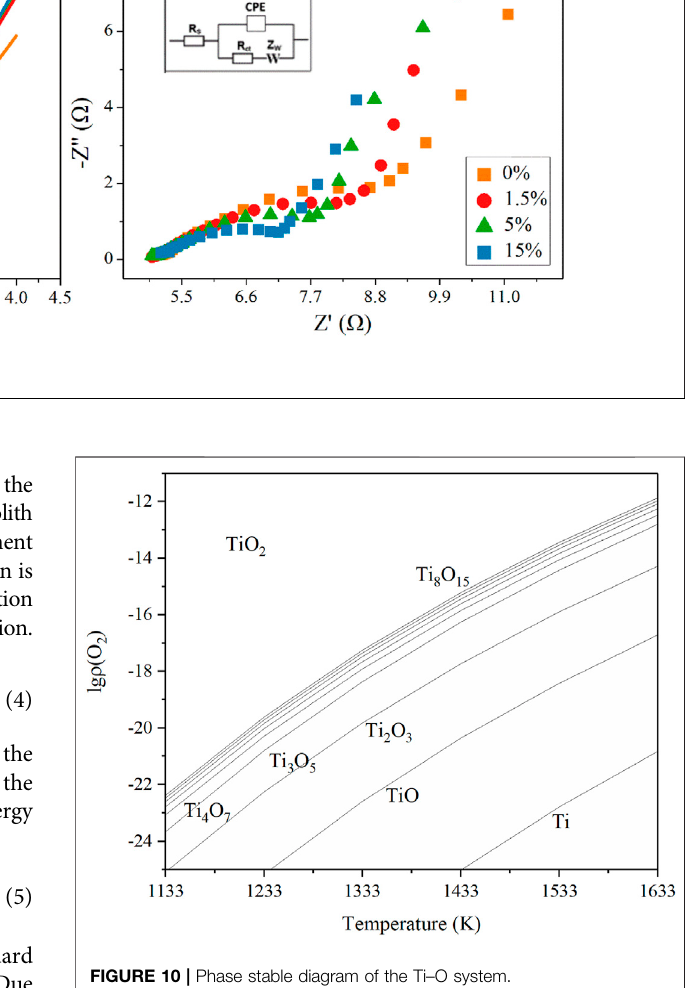
FIGURE 10 | Phase stable diagram of the Ti – O system.